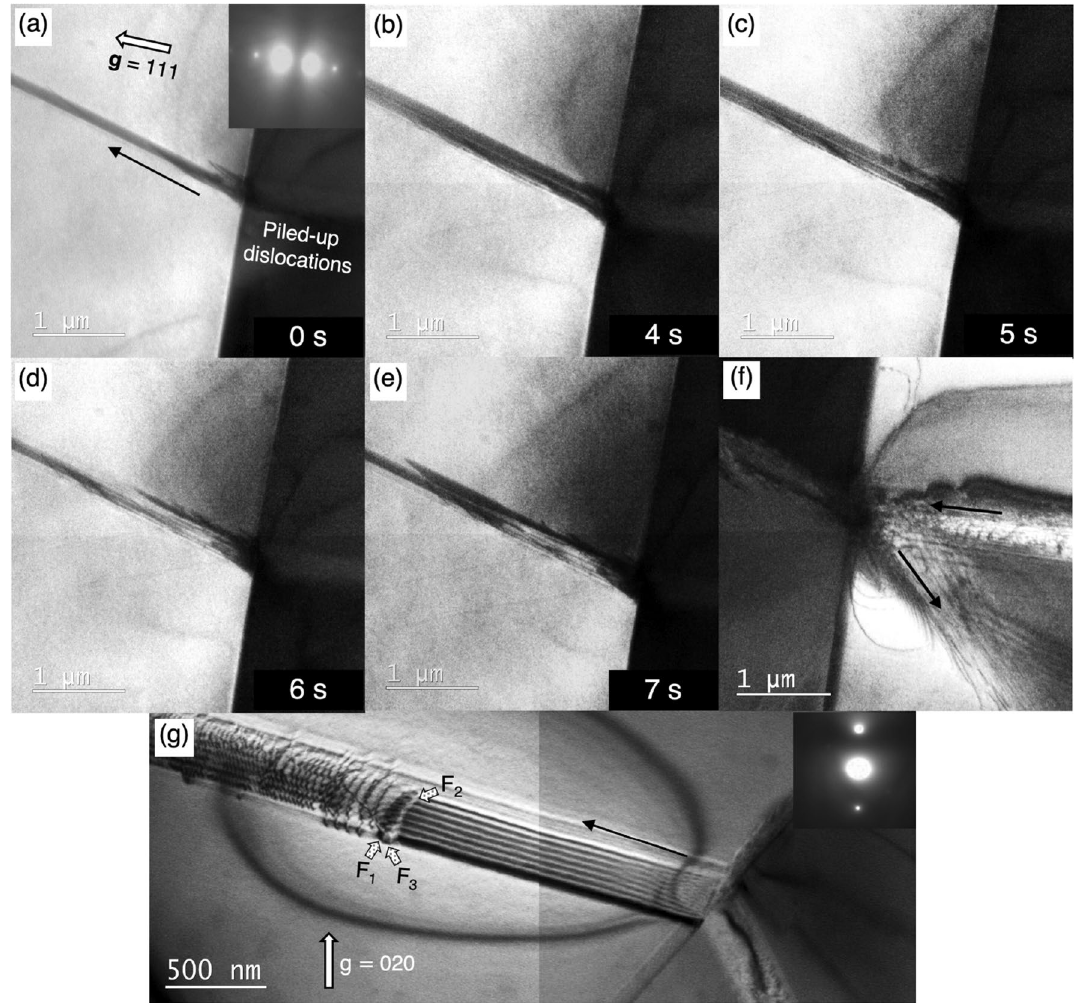
Figure 2. Selected frames of an in-situ deforming TEM test video data (see the original video, Supplementary Video S1 online) showing a near annealing twin boundary region. The video was recorded in the two-beam condition for g = 111 . ( a ) The initial stage of stacking faults emission event. ( b – e ) A continuous emission of stacking faults from the Σ3{111} boundary. The periodic contrast change was observed during the deformation. ( f ) The adjacent grain shows piled-up dislocations impinged on the Σ3{111} boundary and a local stress concentration field near grain boundary region. ( g ) A magnified view shows another stacking fault nucleated from a different Σ3{111} boundary taken in the two-beam condition for g = 020 , near a [ 10 ¯ 2 ] fcc zone axis. The fringe contrast changes were indicated by the arrows filled with dots (F 1 , F 2 , F 3